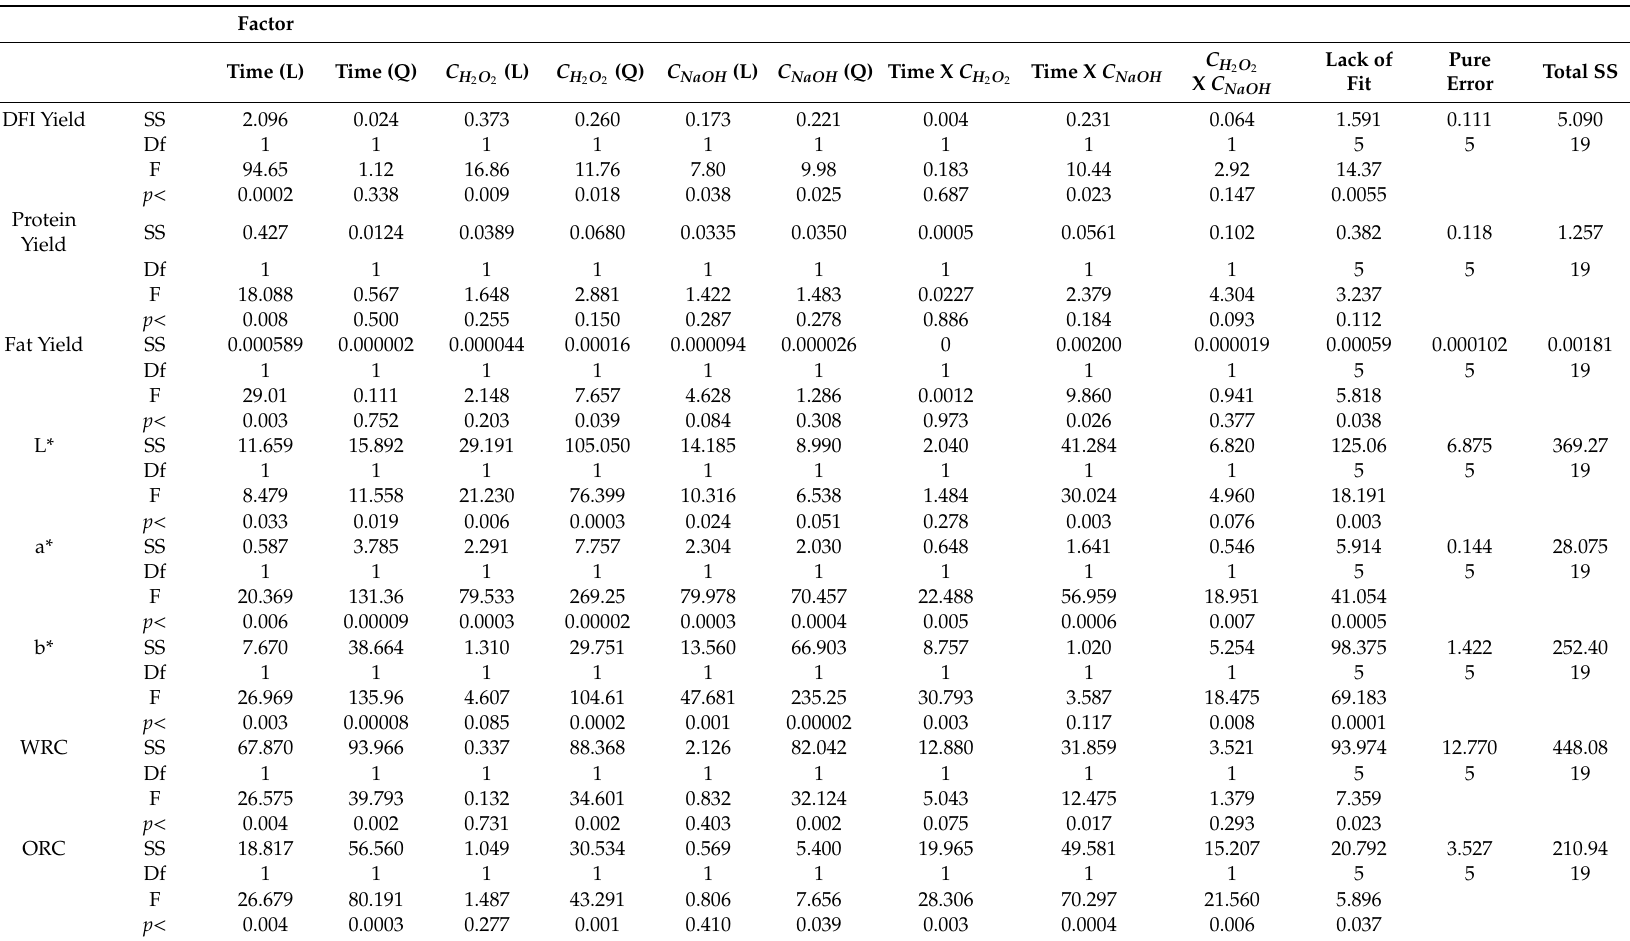
Table 2. Analysis of Variance Results for the physico-chemical and functional response variables of mushroom dietary fiber ingredient